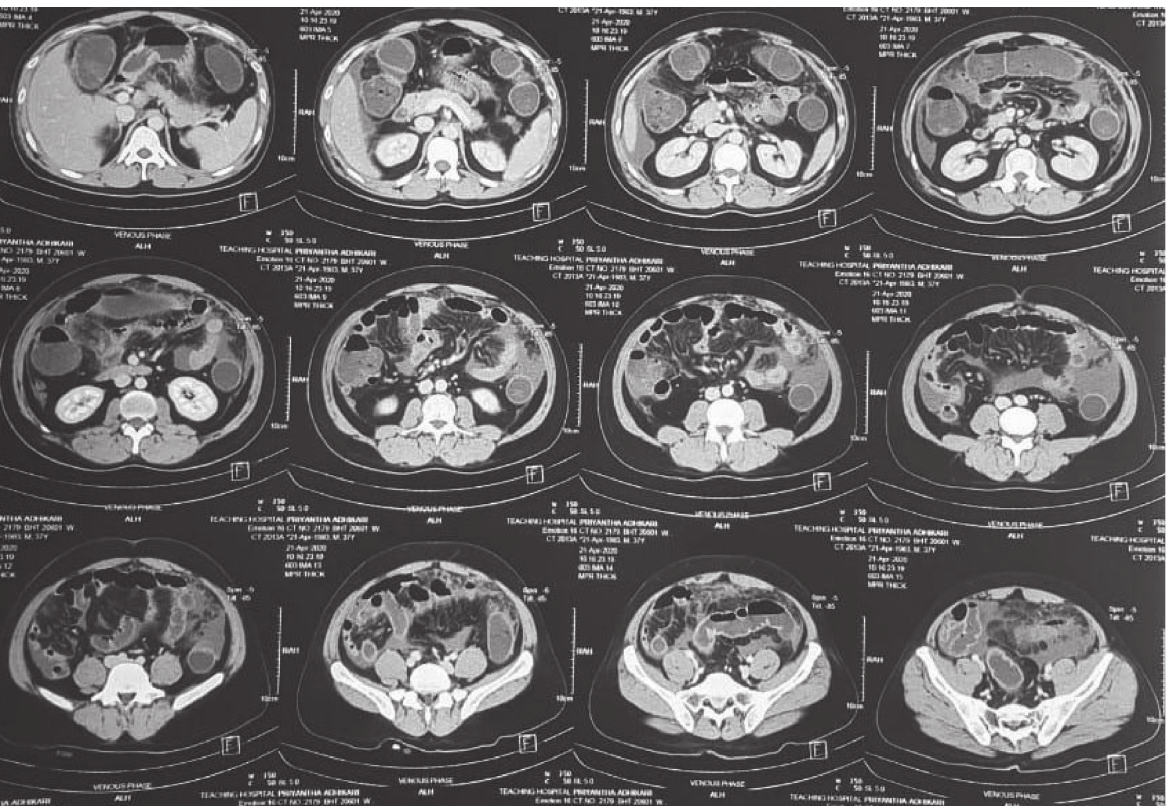
Figure 2: Transverse sections through the abdomen and pelvis demonstrating long thickened retrocecal appendix with minimal in- flammation and moderate amount of free fluids.